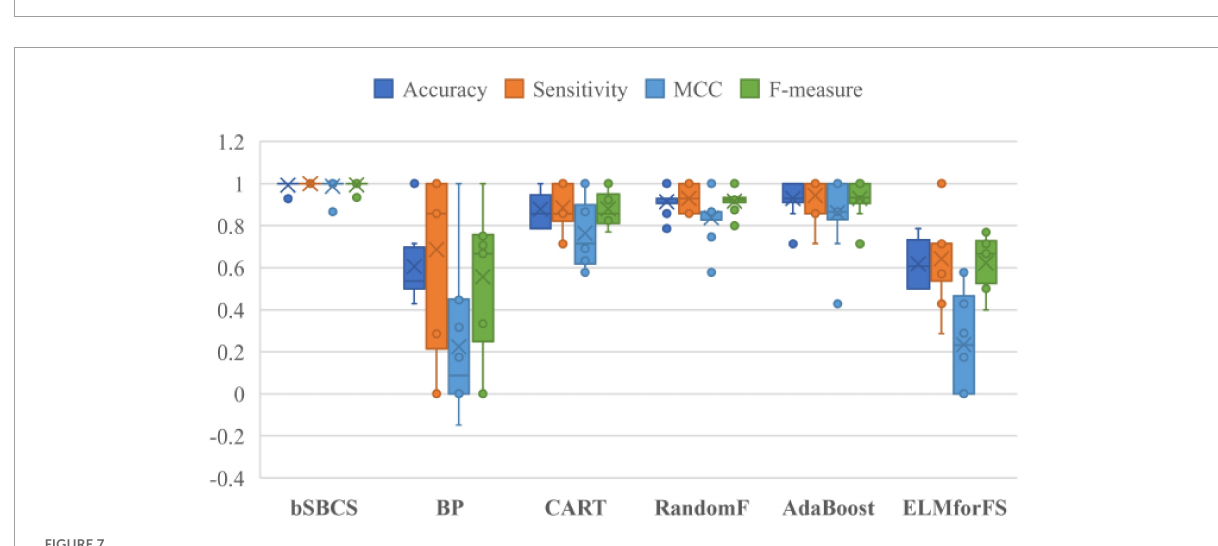
FIGURE6 Comparison results of SBCS on five classifiers.